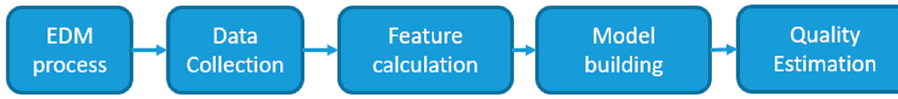
Figure 11. Current and voltage signals of characteristics of EDM.